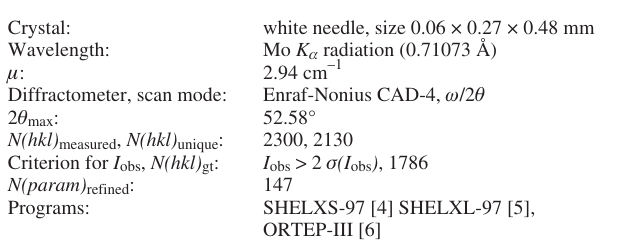
Table 1. Data collection and handling.